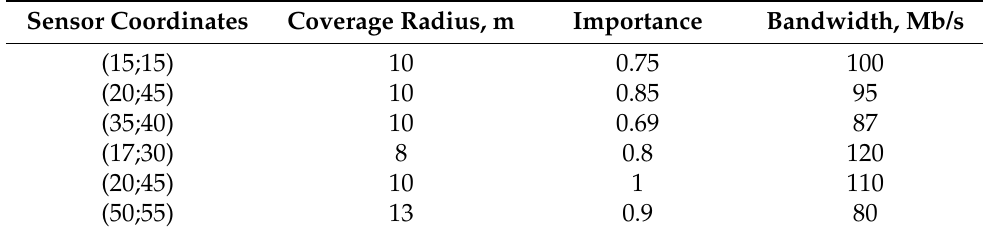
Table 3. Parameters of the estimated network.